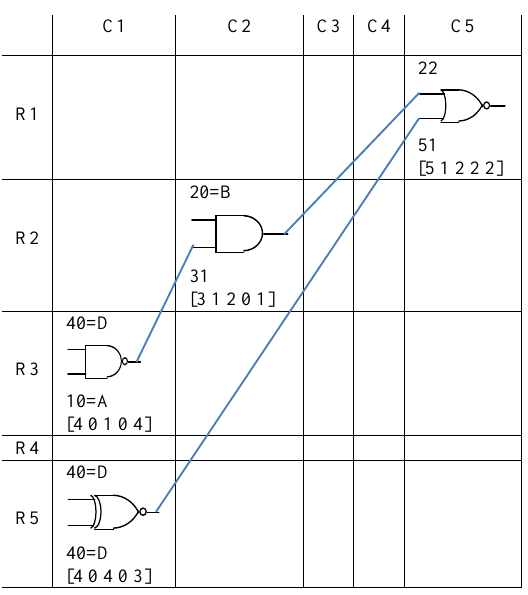
Figure 2. Circuit resulting from first row of figure 1.